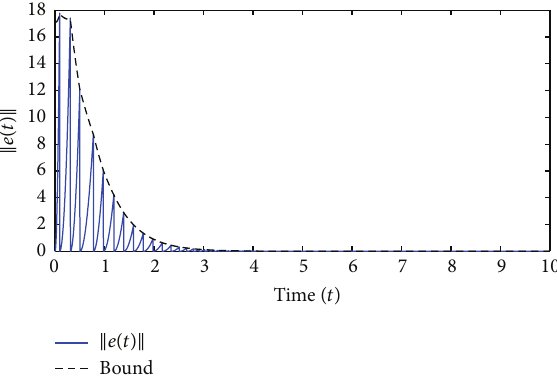
Figure 4: Evolution of the measurement error norm ‖𝑒(𝑡)‖ .